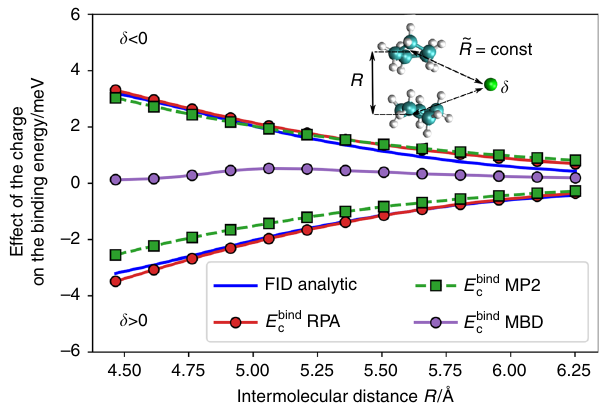
Fig. 3 Field-induced dispersion effect in cyclopentane dimer. FID as a function of intermolecular distance R in Å, calculated at a fi xed distance to the external unit charge ~ R ¼ 5 Å for the cyclopentane dimer (geometry shown as inset). The analytical result is shown in blue. The reference RPA@PBE0 calculations are marked with a red curve. The effect of the charge in conventional vdW methods such as MBD@PBE0 (purple) is negligible. The effect of the charge on MP2@HF correlation energies (dashed green) is visible, however having a different origin than FID. Upper positive halfplane corresponds to the negative sign of the external charge δ = − 1, and negative — to the positive sign δ =